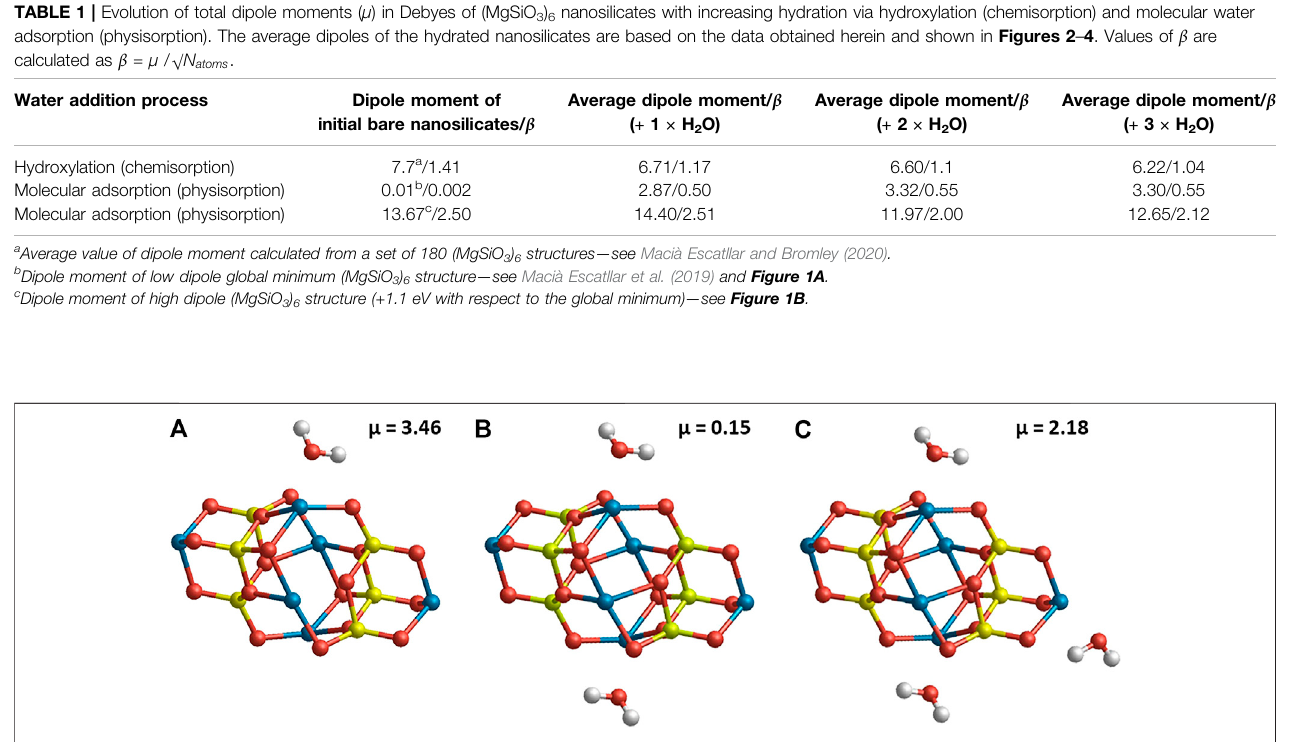
FIGURE4| Lowestenergymolecularlyhydrated(MgSiO 3 ) 6 nanosilicatestructuresstartingfromthelowdipole(see Figure1A )barestructurewith (A) one, (B) two, and (C) three water molecules. Dipole moments for each nanocluster are given in Debyes. Atom color key: silicon – yellow, magnesium – blue, and oxygen — red.